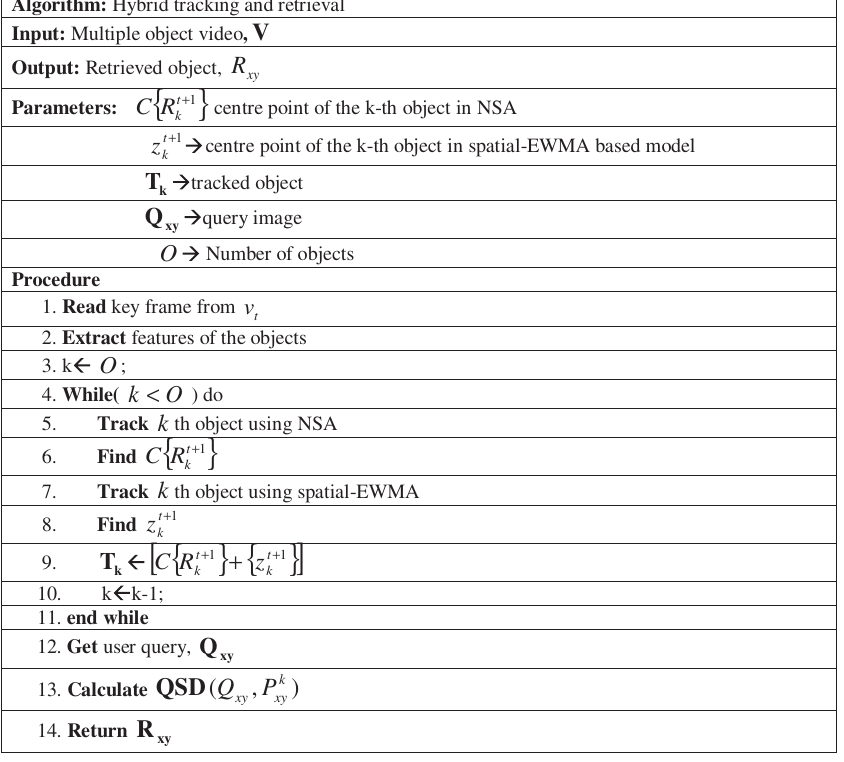
Figure 3: Algorithmic Description of the Proposed